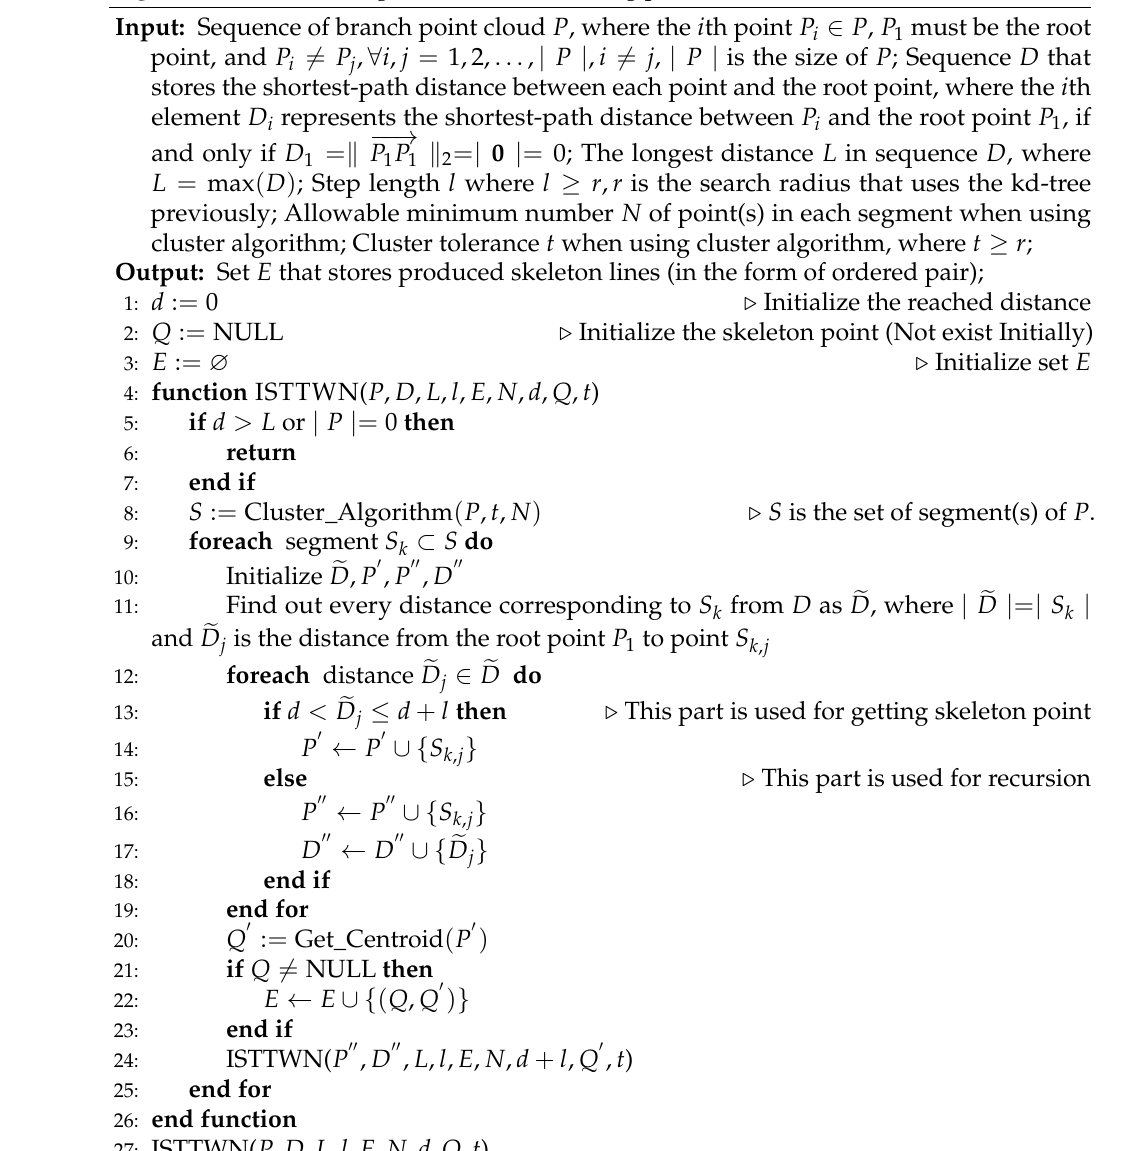
Algorithm 1 ISTTWN algorithm and initializing